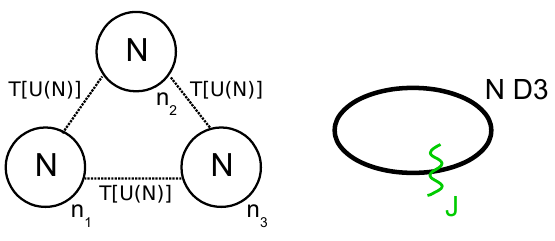
J n J n , and its brane realization. 1 2 3